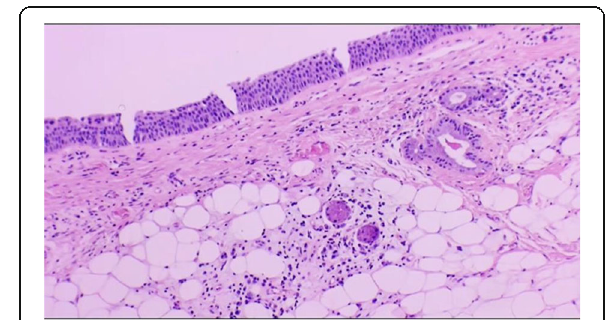
Fig. 2 A mass mainly composed of adipose tissue and epithelial elements. (H&E. 4X)